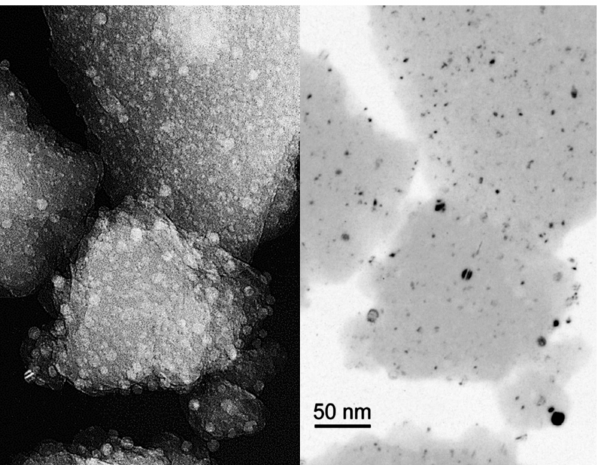
Figure 7. Example TEM images of the preparation, magnified 100,000 times (on the left-hand side) and the image obtained through the use of the dark field method, which enables the crystallites to be counted (on the right-hand